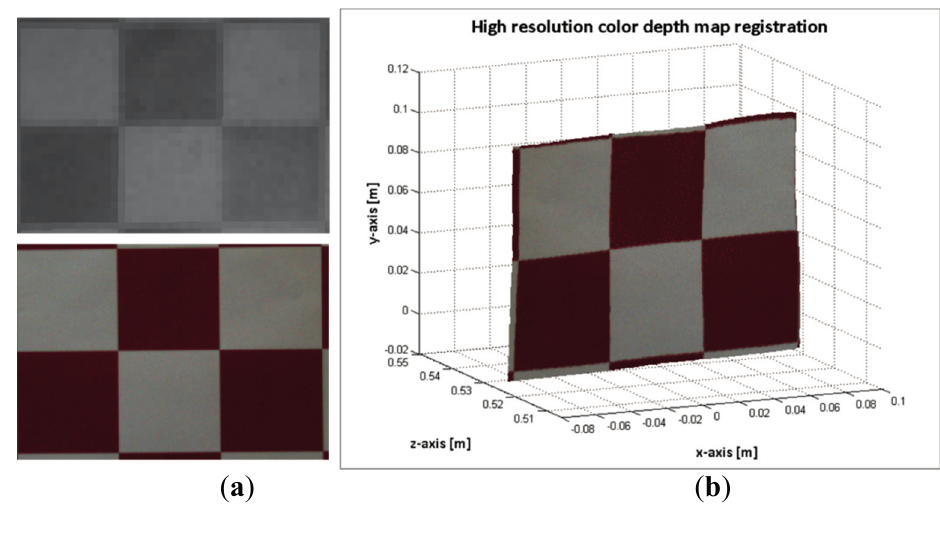
Algorithm 3 Procedure for mapping points between two views (ToF ↔ RGB) based on the